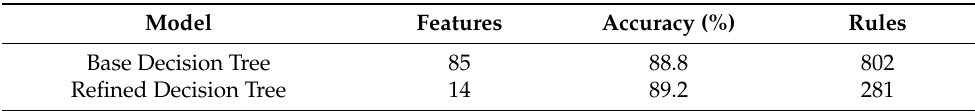
Table 2. Linguistic terms for input and output fuzzy